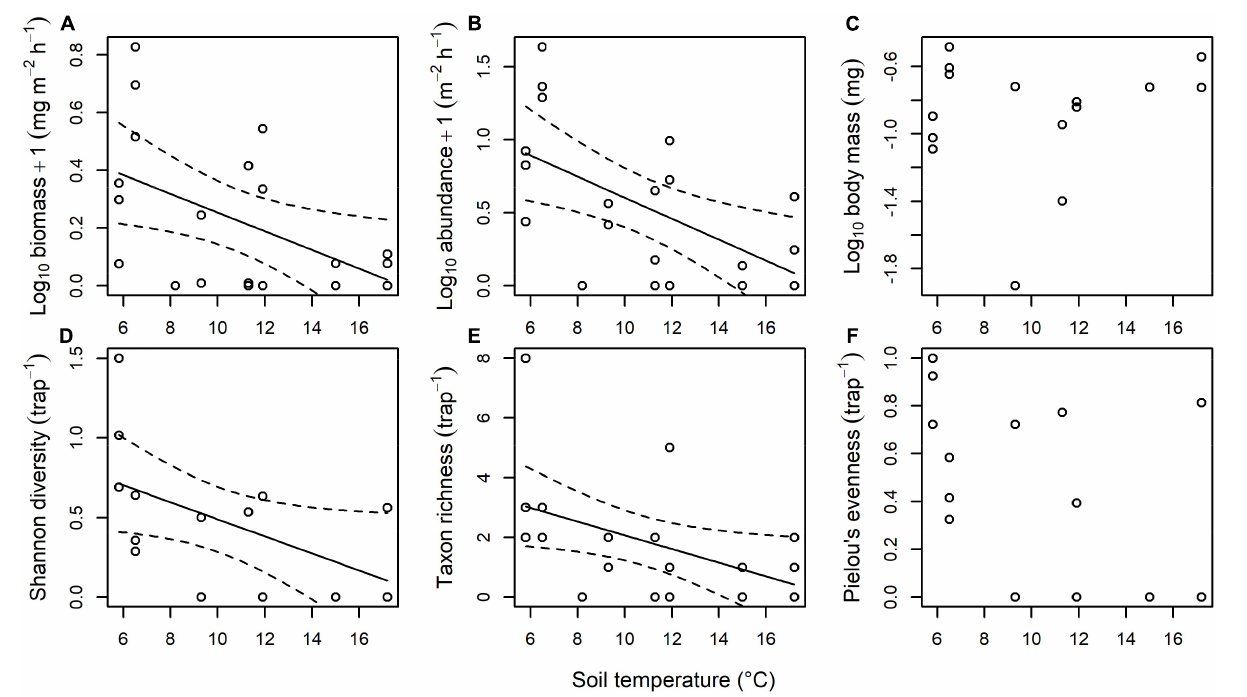
FIGURE 6 | Effect of stream temperature on the terrestrial subsidy of invertebrates drifting through the streams. There was a significant effect of temperature on (A) biomass ( y = 0.578 – 0.032 x , p = 0.024, r 2 = 0.21), (B) abundance ( y = 1.325 – 0.072 x , p = 0.008, r 2 = 0.29), (D) Shannon diversity ( y = 1.026 – 0.054 x , p = 0.045, r 2 = 0.22), and (E) taxon richness ( y = 4.366 – 0.230 x , p = 0.035, r 2 = 0.18), with no significant effect of temperature on (C) body mass or (F) Pielou’s